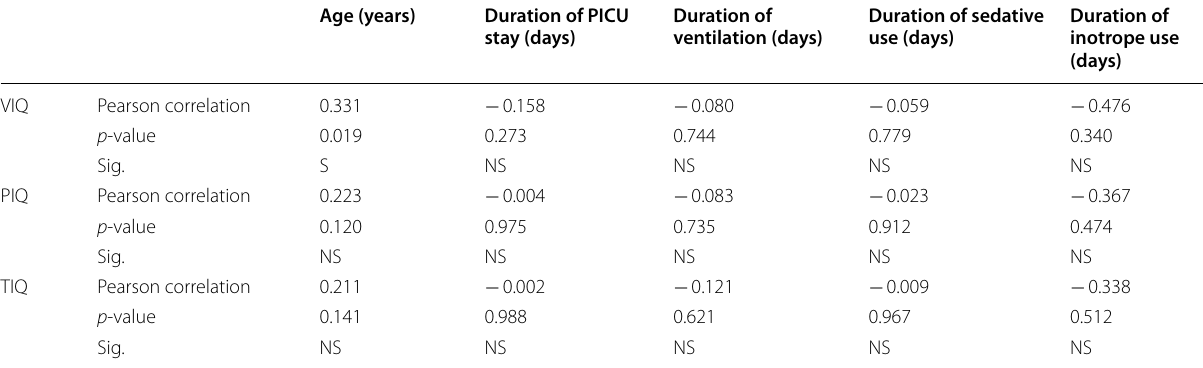
Table 3 Correlations between intelligence quotient domains and patients’ age, PICU stay length, mechanical ventilation duration, and inotropic support